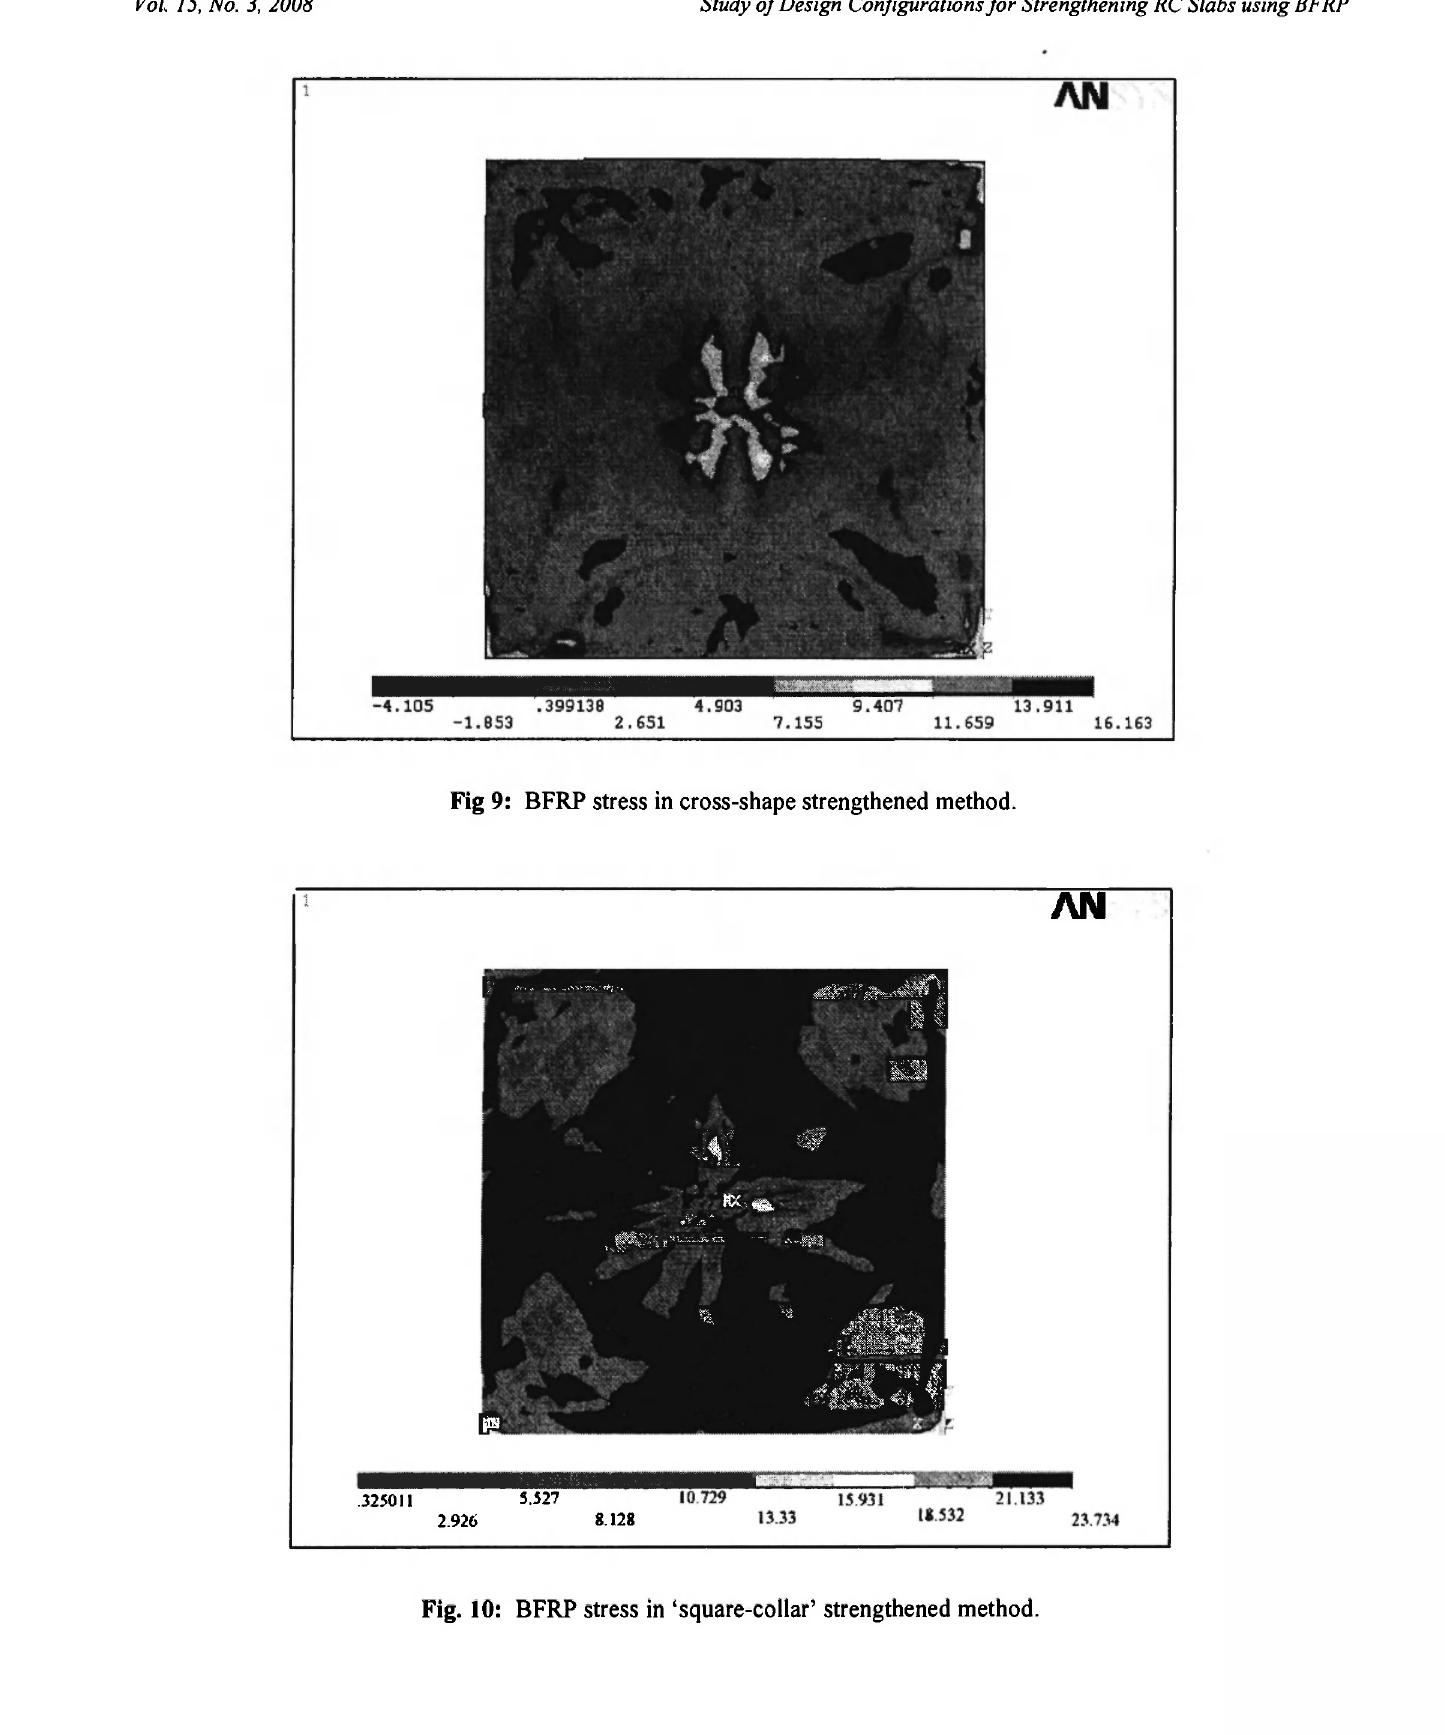
Fig. 10: BFRP stress in 'square-collar' strengthened